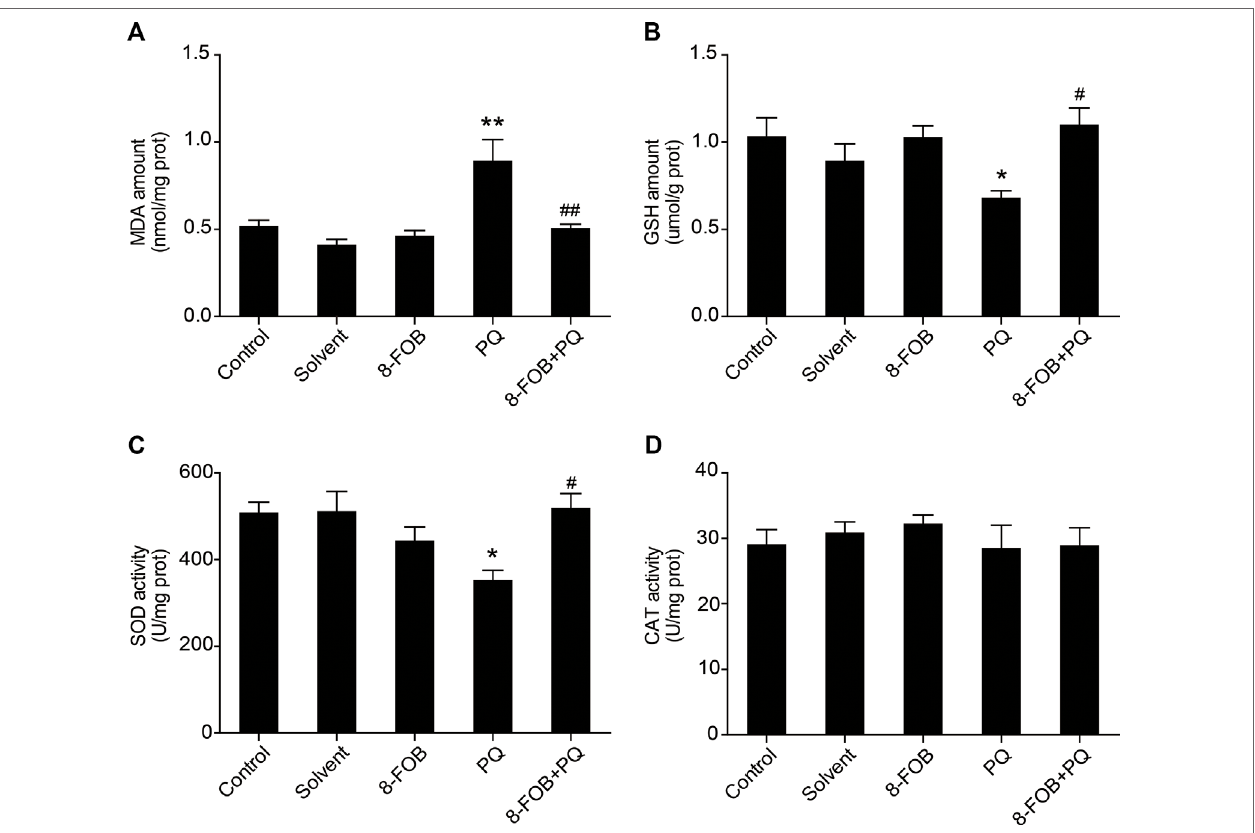
FIgURe 7 | 8-Formylophiopogonanone B (8-FOB) attenuates paraquat (PQ)-induced hepatic oxidative stress in mice. Changes in the malondialdehyde (MDA) amount (A) , glutathione (GSH) content (B) , superoxide dismutase (SOD) activity (C) , and catalase (CAT) activity (D) in the liver. The values are presented as the means ± SEM ( n = 5). * p < 0.05, ** p < 0.01 vs the control group; # p < 0.05, ## p < 0.01 vs the PQ